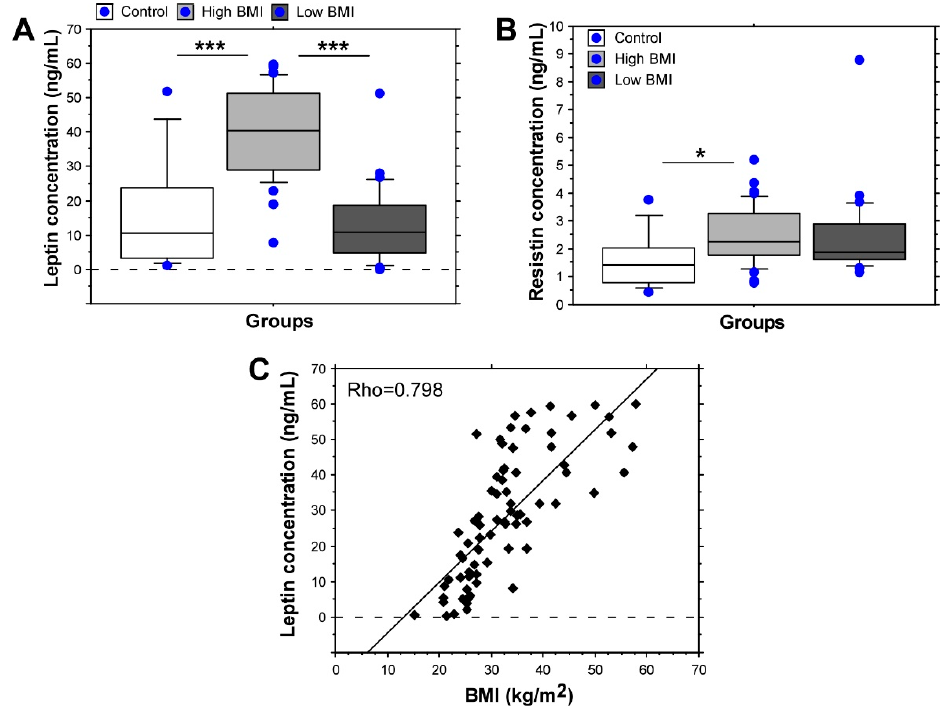
Figure 1. Leptin and resistin serum levels in knee OA patients. ( A ) Leptin concentration; ( B ) resistin concentration; ( C ) correlation between leptin serum levels and BMI; * p < 0,05; *** p < 0.001.